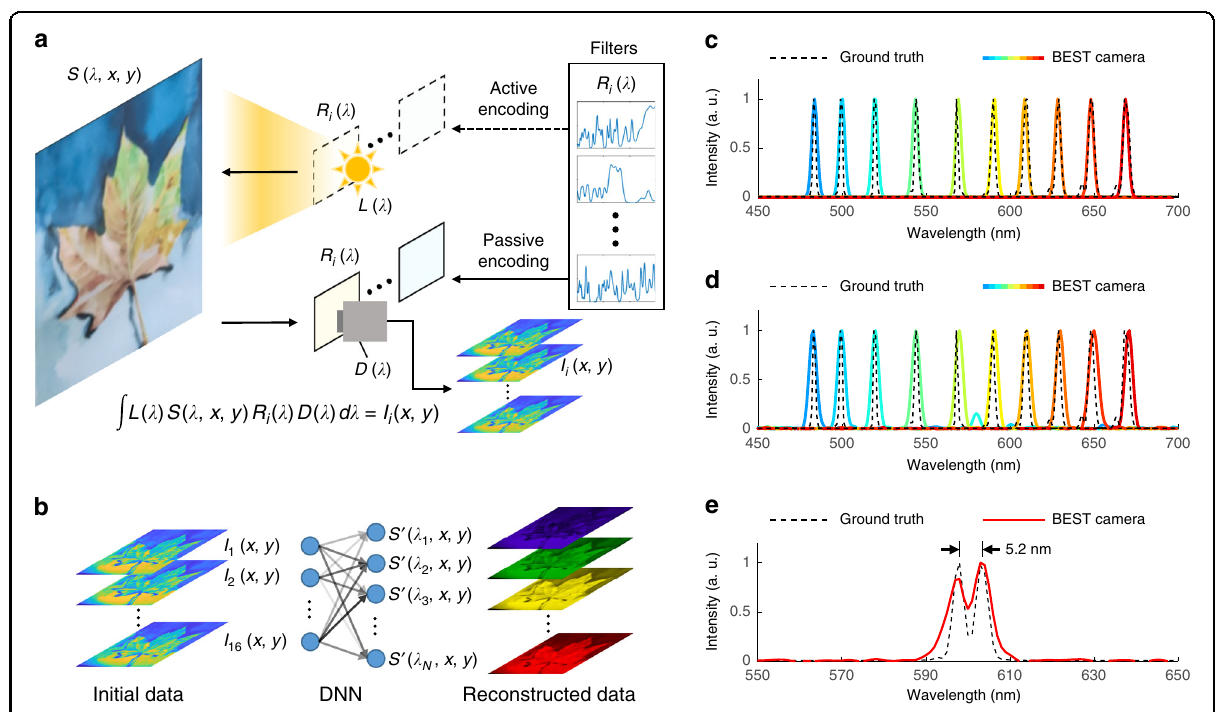
Fig. 1 Principle and performance of BEST camera. a Simpli fi ed schematic. Depending on where the light spectrum is encoded, the camera can work either in the active (upper) or passive (lower) modes. b Principle of DNN-based spectral reconstruction algorithm. The initial data captured by the monochrome camera is fed into the DNN and outputs the reconstructed 3D hyperspectral data cube. c , d Spectral pro fi les of laser beams with narrow bandwidth. In c , the DNN is trained by the “ precise ” dataset, whereas d is for the results from the DNN trained by “ general ” datasets. E Spectral pro fi le of two peaks corresponding to 598.0 nm and 603.2 nm. The peak-to-peak distance is highlighted in black. In c – e , the ground truths and the DNN reconstructed results are represented by dashed (ground truth) and solid (reconstructed) curves, respectively. The graphs are normalized to their peak